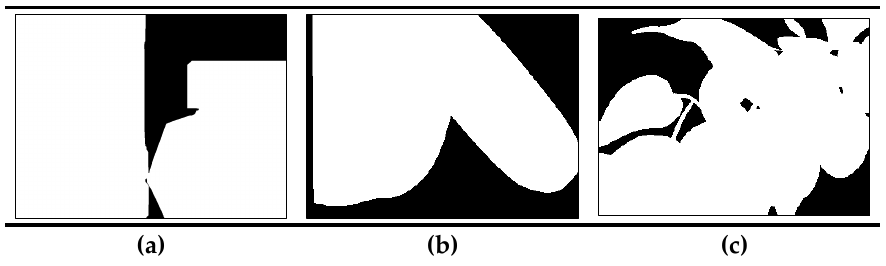
Figure 10. Ground truths of the MSPI dataset for: ( a ) liquid scene, ( b ) food scene, ( c ) leaf scene.